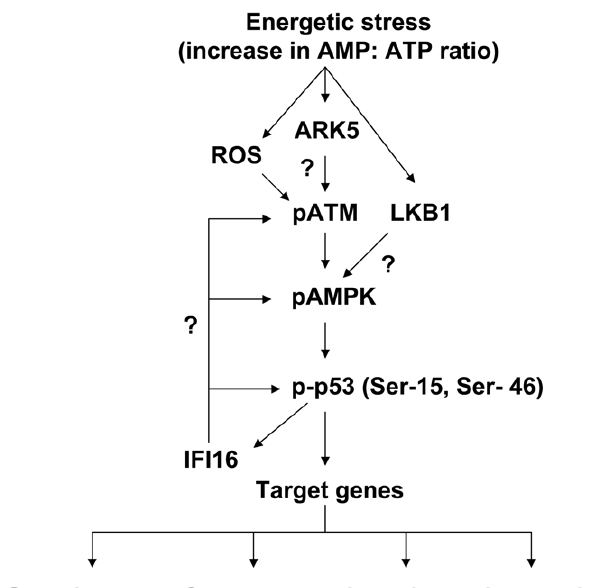
Figure 7. Proposed model for the regulation and role of the IFI16 protein in glucose restriction-induced activation of the ATM/AMPK/p53 pathway and autophagy.